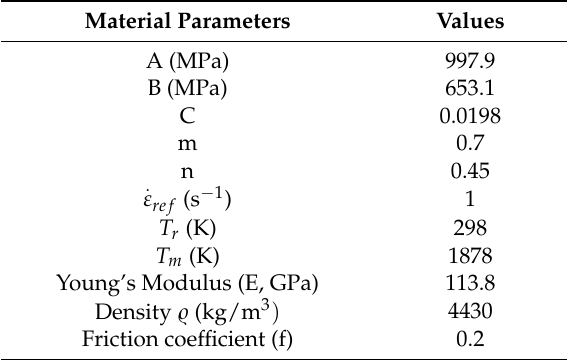
Table 1. Material properties of the